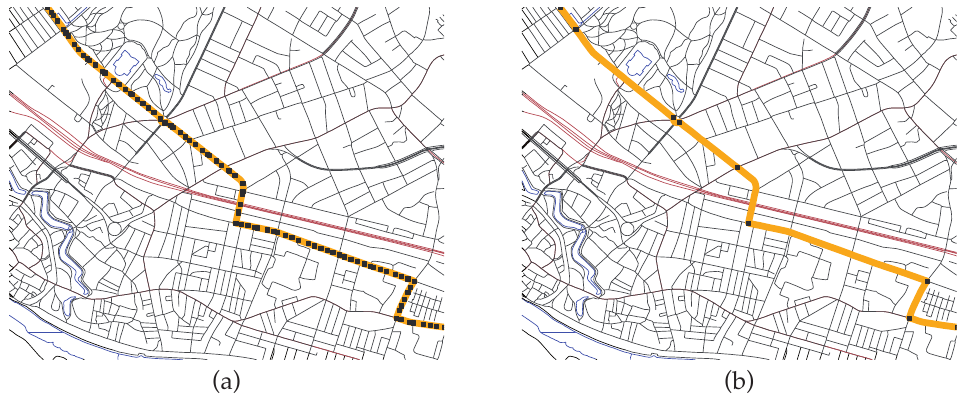
Figure 6: The map shows a part of Bremen where tests have been performed in. As an example, one of the 18 real world trajectories is shown (trajectory #9 of Table 2). The Figure shows in (a) the original trajectory (bold line). The dots represent the fi xes mapped to the street network; and in (b) the dots represent the reference points stored in the compressed